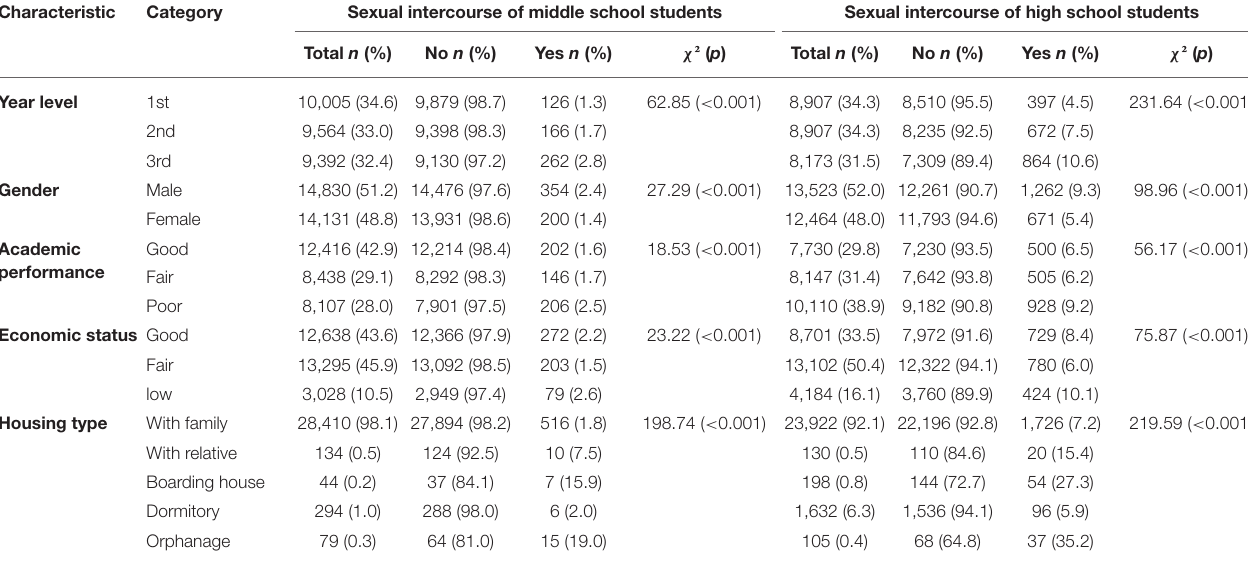
TABLE 1 | Demographic characteristics of the participants ( n =